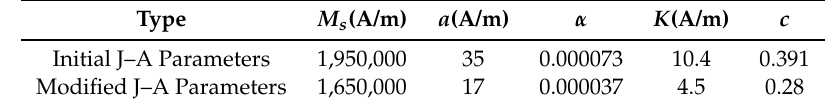
Table 2. Initial and modified J–A parameters.